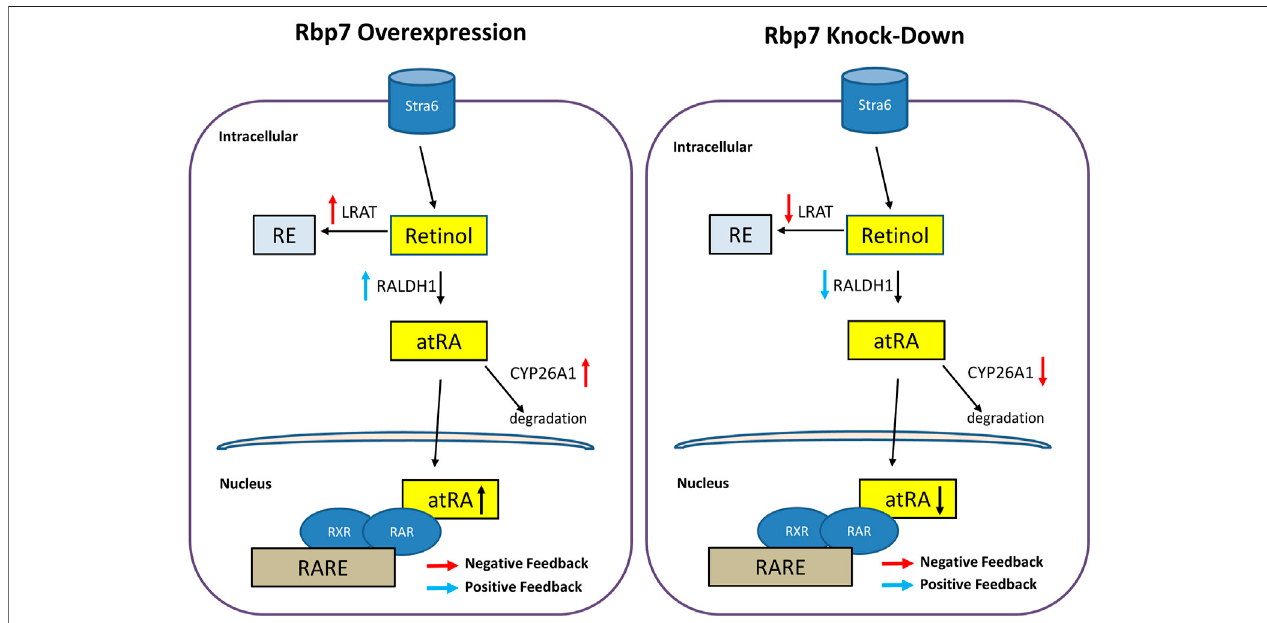
FIGURE6| Schematic diagramillustrating hypotheticalregulationofnuclearRAactivitiesand expressionsofgenes/proteinsinvolvedintheretinoidmetabolism by Rbp7. When Rbp7 is overexpressed, LRAT and CYP26A1 proteins are up-regulated and RALDH1 is down-regulated which might be caused by negative or positive feedback of increased atRA, respectively. In contrast, knock-down of Rbp7 induces down-regulations of LRAT and CYP26A1 and up-regulation of RALDH1 via the feedback mechanisms.